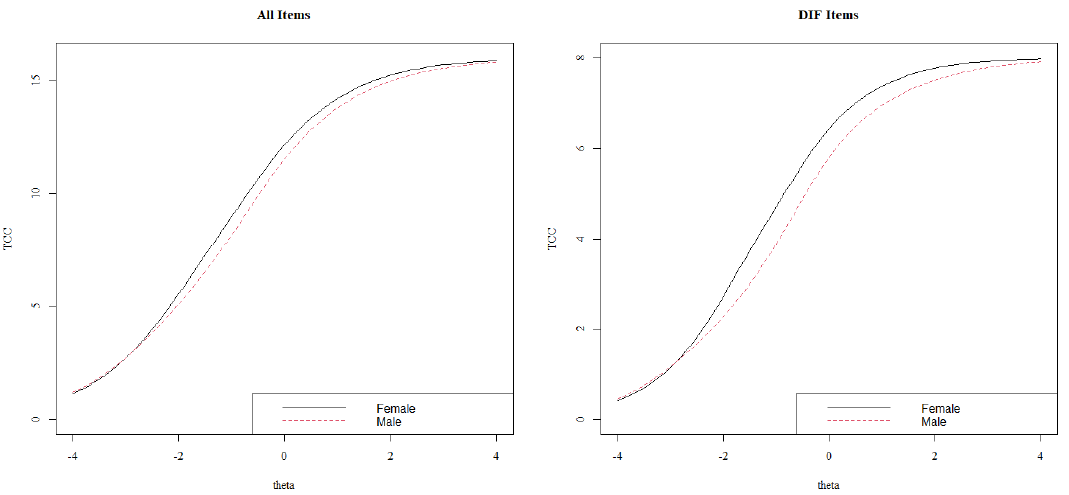
Figure 8. Tests characteristics curves (TCCs) by group.